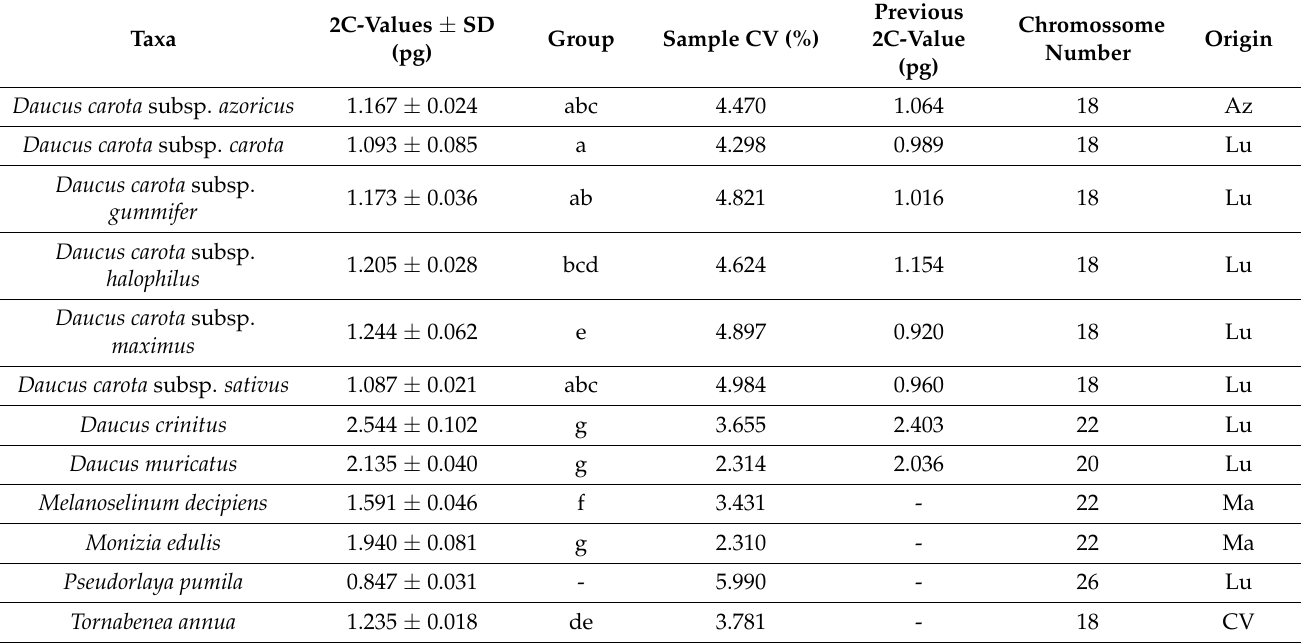
Table 3. Cytogenomic results obtained for 16 taxa. Average 2C-values in picograms with standard deviation (SD), group (the same letter(s) indicates species within the genus that are not significantly different), sample coefficient of variation as a percentage (CV), previous 2C-value estimates in pictograms based on a previous study [49], and the origin of the collected specimens (Az, Azores; CV, Cabo Verde; Lu, mainland Portugal; Ma, Madeira). The number of chromosomes retrieved from the literature [see references in Section 4.3. Data Collection] is also